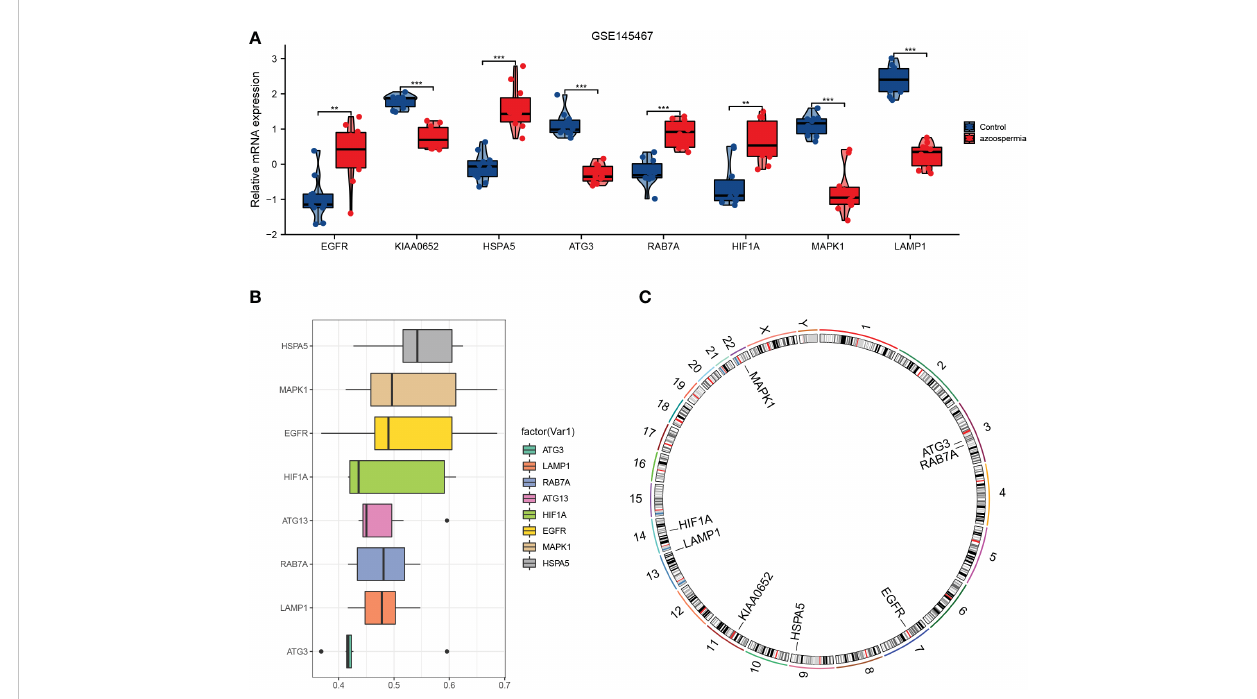
FIGURE 6 Expression (A) , semantic similarity (B) , and chromosome distribution (C) of hub genes. *P<0.05, **P<0.01, ***P<0.001.